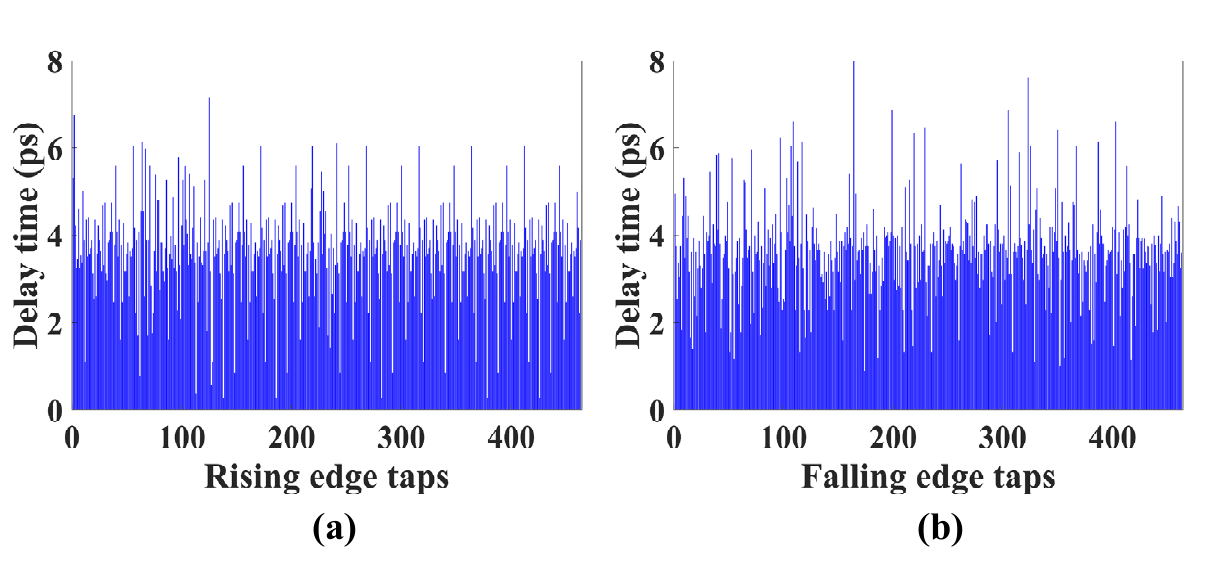
Figure 12. Measured histogram in the carry chain ( a ) rising edge; ( b ) falling